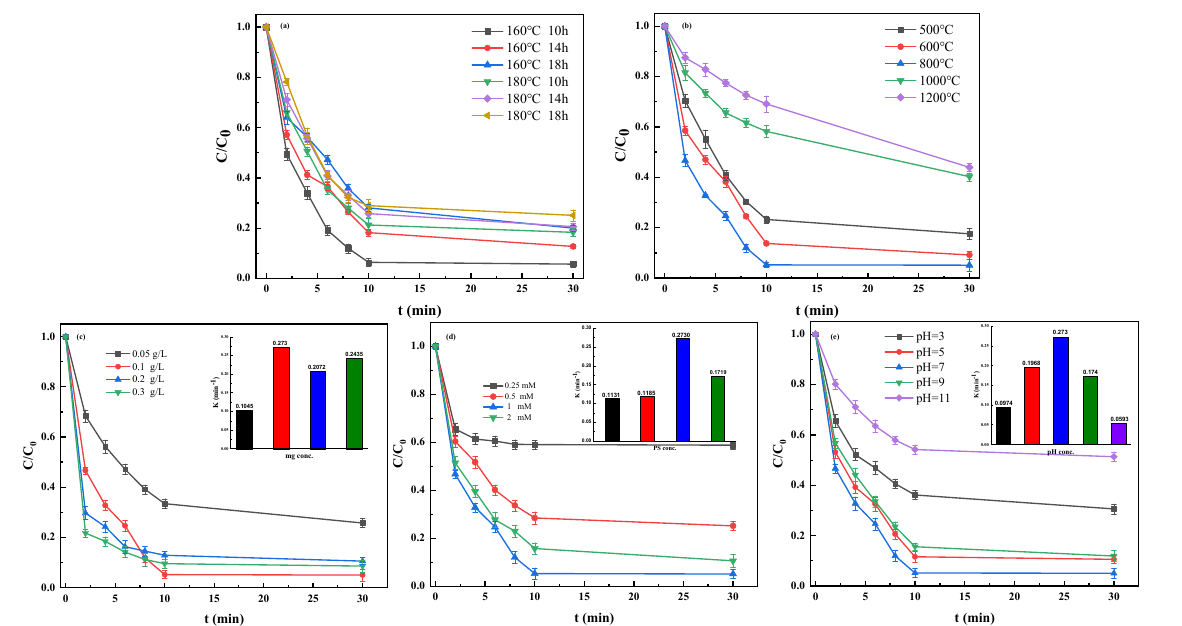
Figure 2. Effects of hydrothermal temperature, time ( a ), calcination temperature ( b ), Fe@MC dosages ( c ) ([PS] = 1 mM; [TBBPA] = 10 mg·L − 1 ; pH= 7), PS dosages ( d ) (Fe@MC dosage = 0.1 g·L − 1 ; [TBBPA] = 10 mg·L − 1 ; pH = 7) and initial pH ( e ) (Fe@MC dosage = 0.1 g·L − 1 ; [PS] = 1 mM; [TBBPA] = 10 mg·L − 1 ) in the Fe@MC/PS system. (The internal illustrations show reaction rates under different conditions).